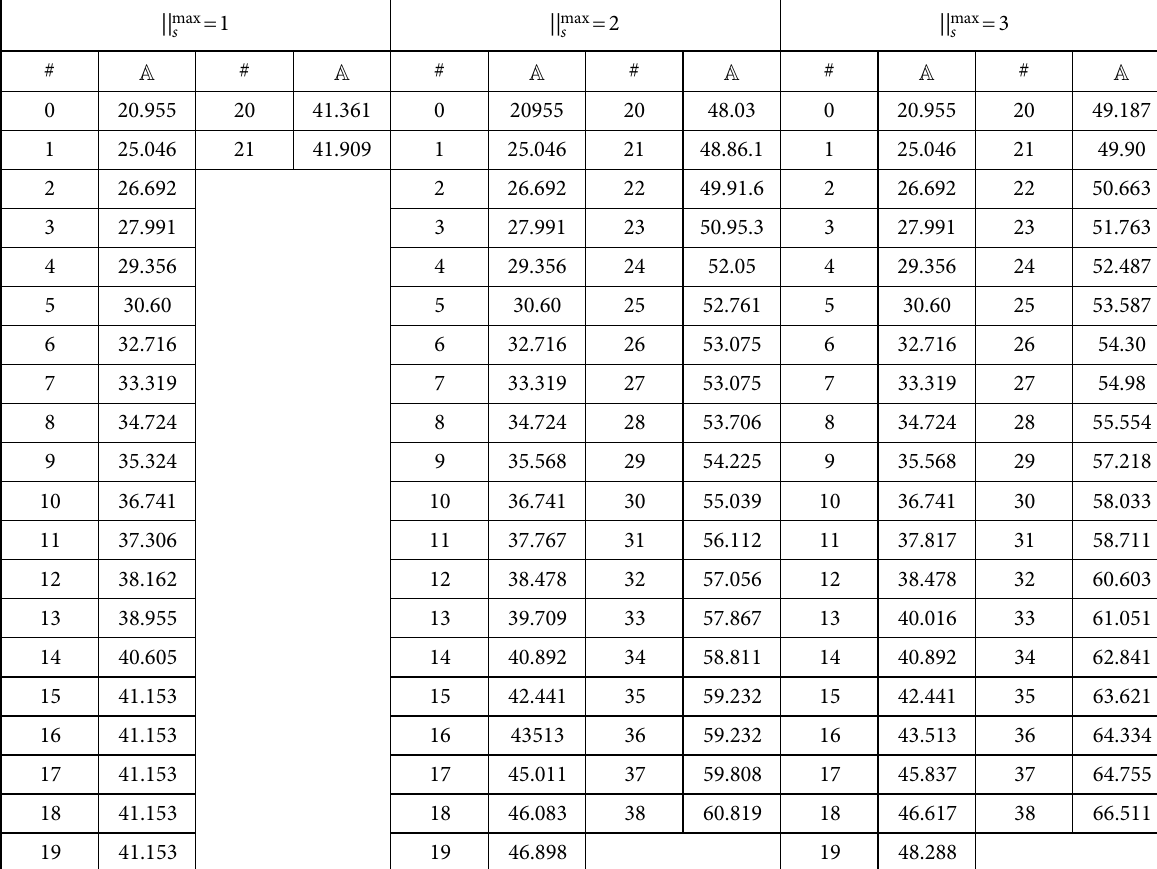
Table 10. Result of expansion model (no flow